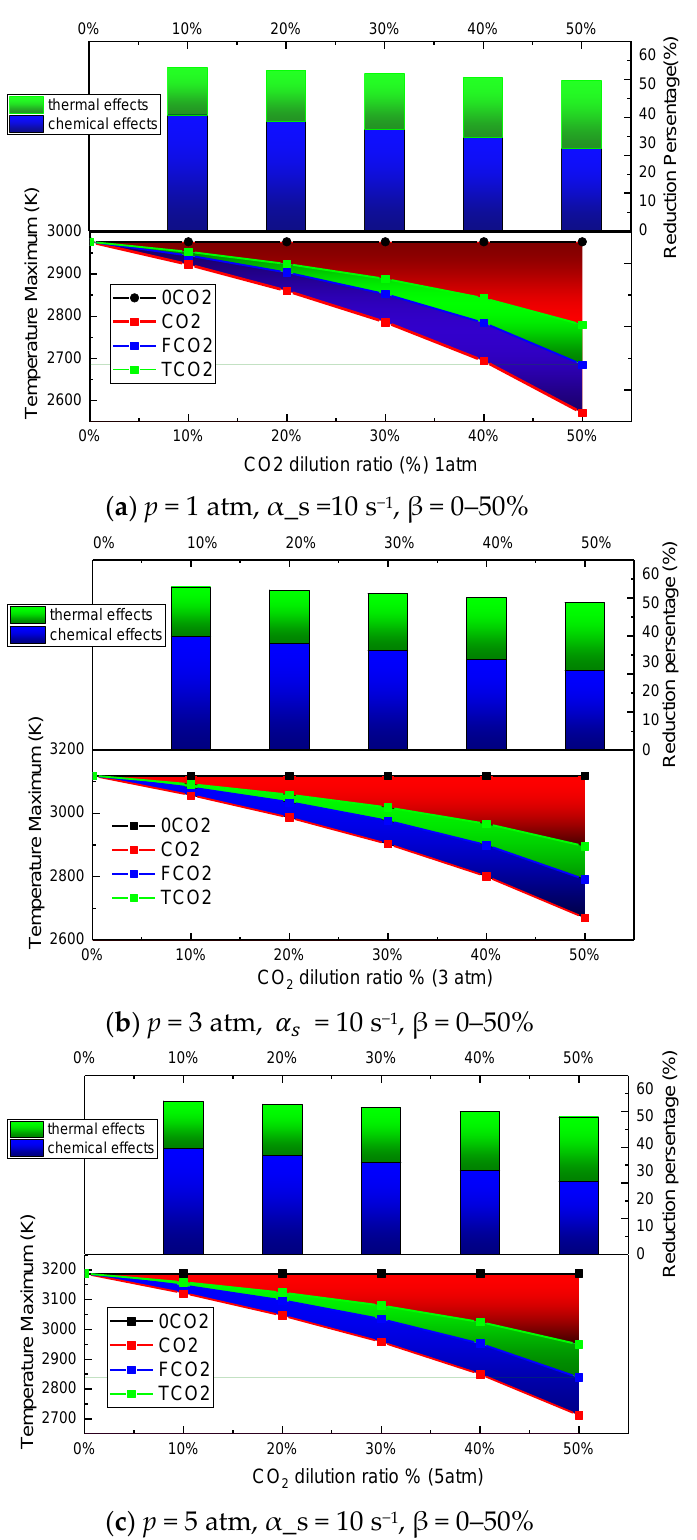
Figure 6. The comparison of the chemical effect and thermal effect on the maximum flame temper- ature with different pressure at 𝛼 𝑠 = 10 s −1 , β = 0–50%.